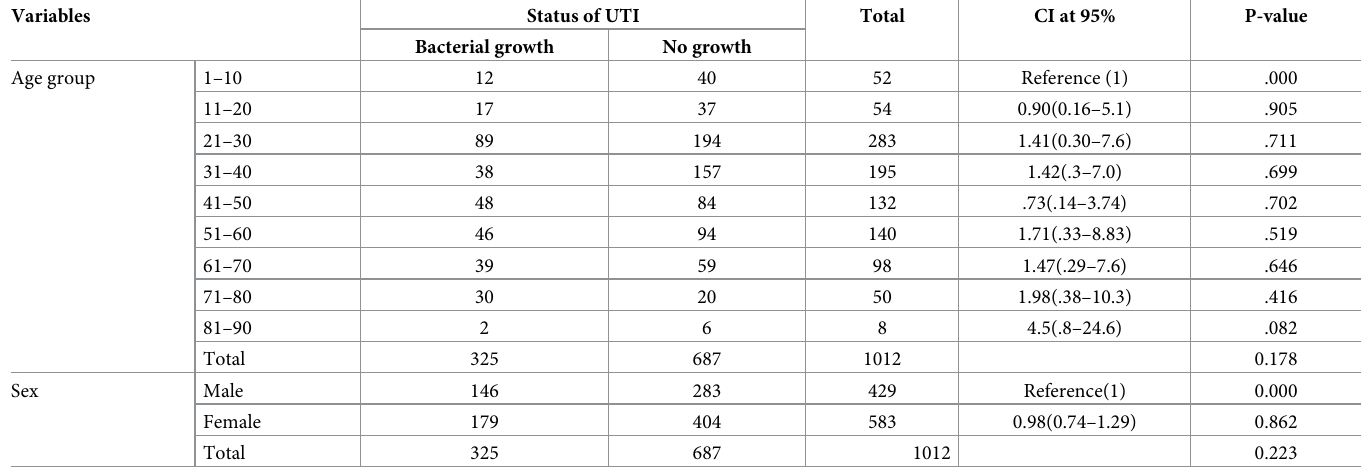
Table 1. Age and sex distribution of patients referred to